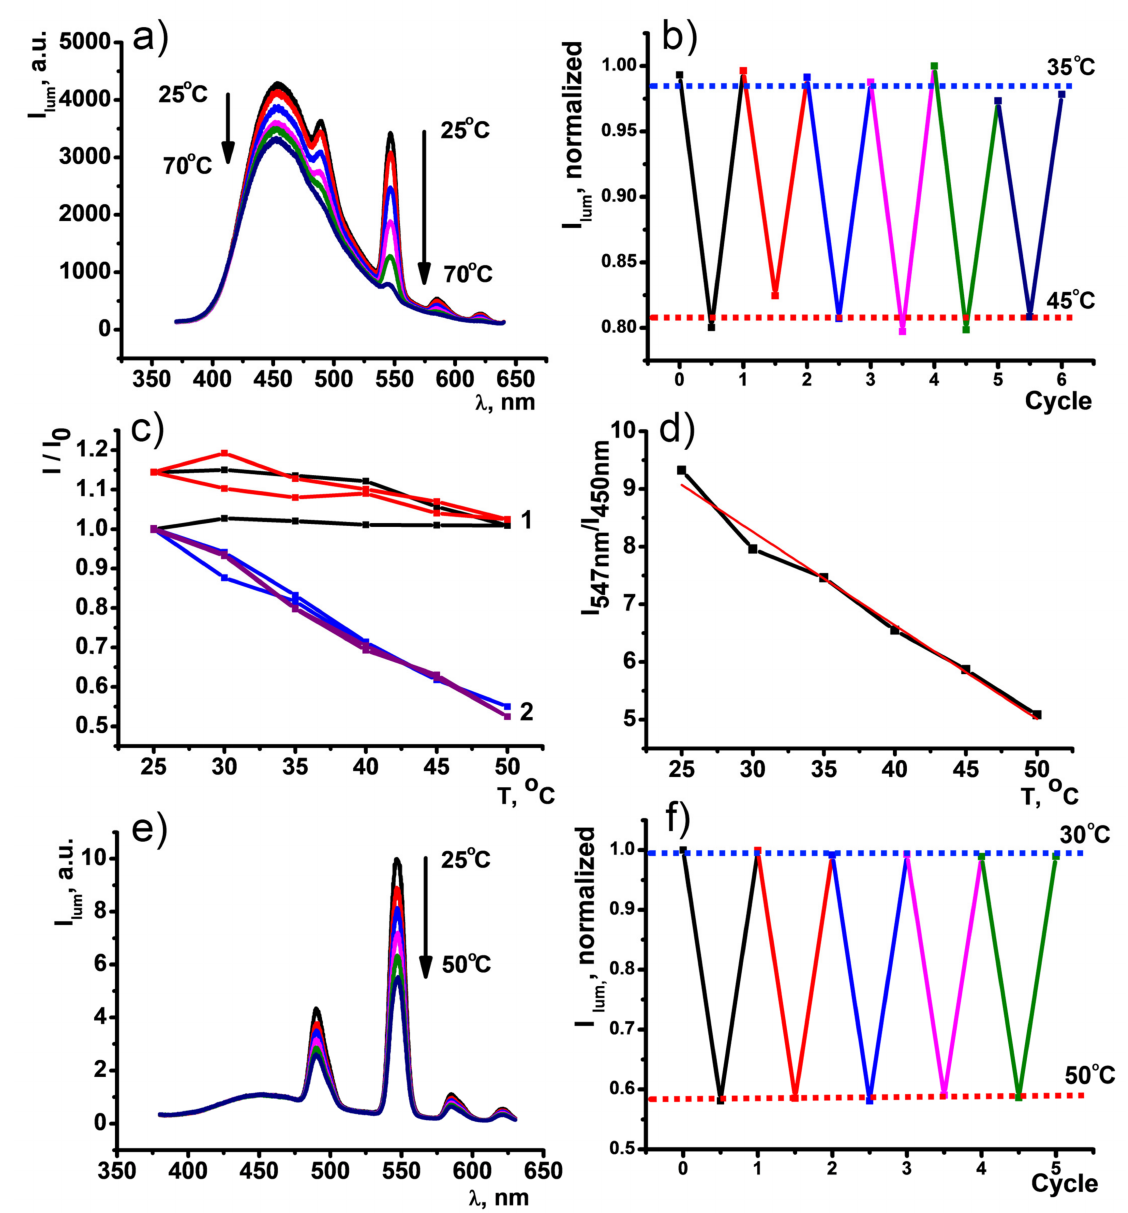
Figure 9. ( a ) Emission spectra of the PSS-{CDs-[TbL]} ( Synthesis_1 ) (l ex = 360 nm) as a function of temperature over the 25–50 ◦ C range. ( b ) Temperature dependence of 547 nm band of PSS-{CDs-[TbL]} ( Synthesis_1 ) upon seven heating- cooling cycles under alternating temperatures of 35 ◦ C and 45 ◦ C. ( c ) Temperature dependence of 450 nm (1) and 547 nm (2) bands of PSS-{CDs-[TbL]} ( Synthesis_2 ) upon two heating-cooling cycles (first cycle colored by black and blue for 450 nm and 547 nm; second cycle colored by red and purple for 450 nm and 547 nm, respectively). ( d ) I 547 /I 450 value versus temperature within the range of 25–50 Celsius degrees. ( e ) Emission spectra of the PSS-{CDs-[TbL]} ( Synthesis_2 ) (l ex = 360 nm) as a function of temperature over the 25–50 ◦ C range. ( f ) Normalized fluorescence intensity upon four heating-cooling cycles of PSS-{CDs-[TbL]} ( Synthesis_2 ) under alternating temperatures of 30 ◦ C and 50 ◦